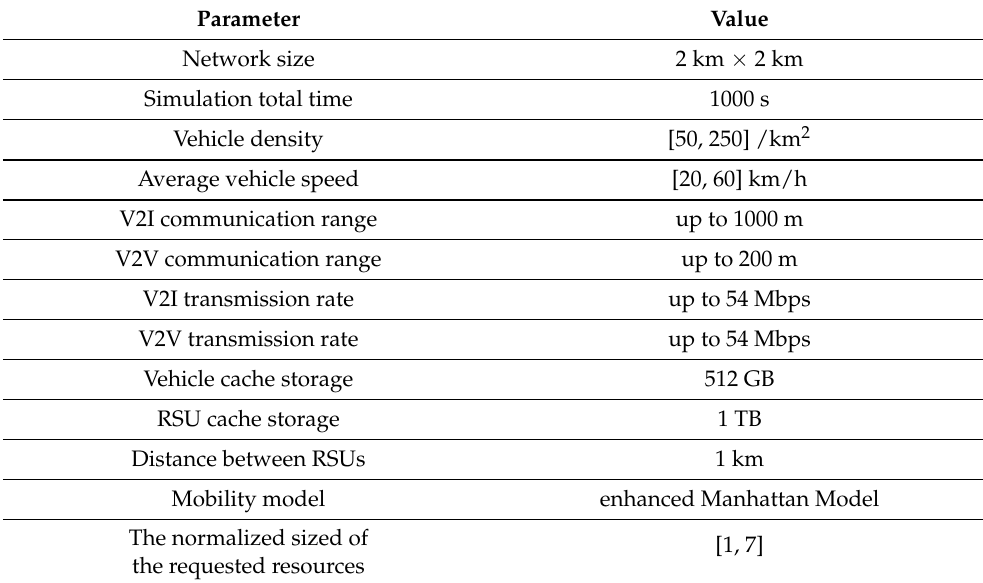
Table 2. Parameter settings of the proposed